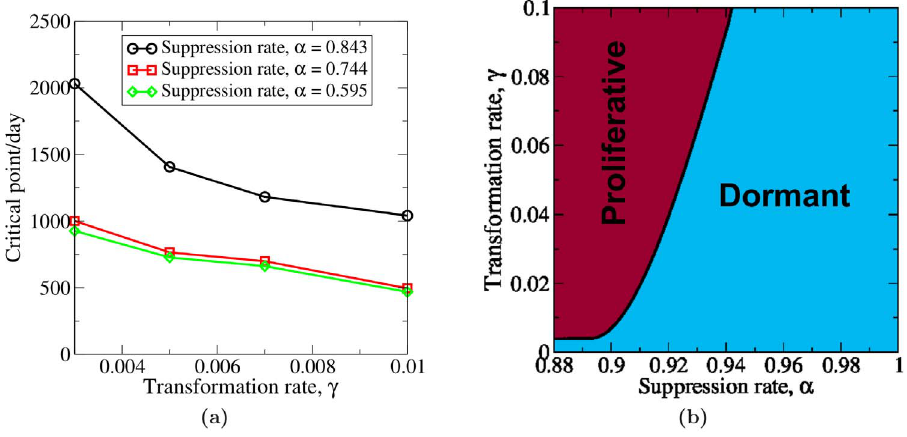
Figure 4. The ‘‘critical’’ point at which the noninvasive tumor growing in the ECM with (cid:2) rr ECM ~ 0 : 3 switches from a dormant state to a proliferative state as functions of a and ª (a). A schematic phase diagram that characterizes the growth dynamics of a noninvasive tumor growing in the ECM with (cid:2) rr ECM ~ 0 : 3 under different a and c (b).